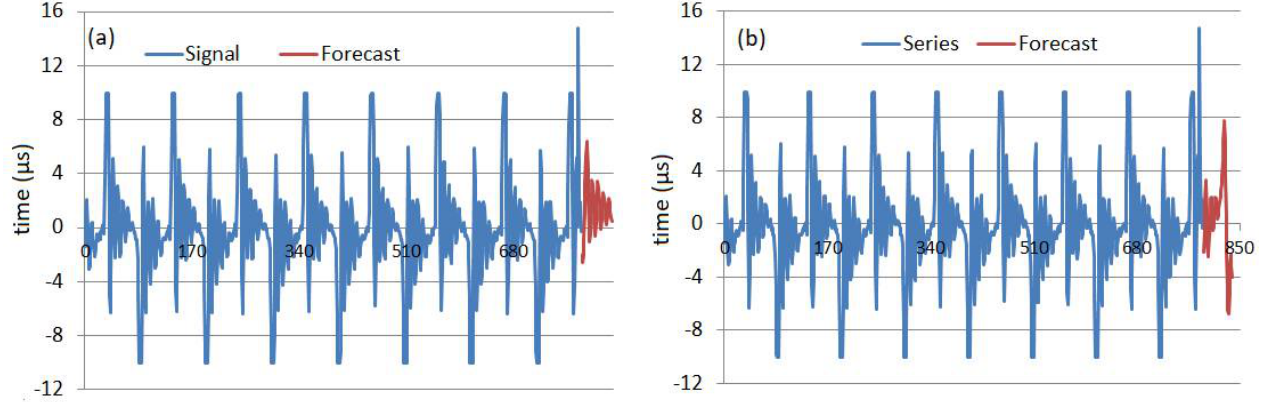
Figure 11. The signal (blue) and the forecast (red) in ( a ) the Wavelet-ARIMA and ( b ) Wavelet-ANN model (red).